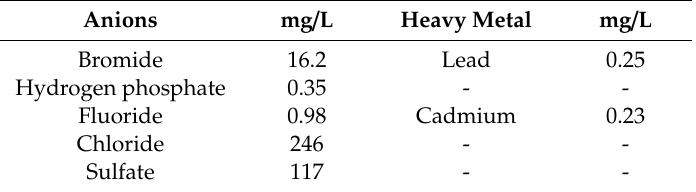
Table 2. Original concentrations of elements of interest for water quality in the analyzed